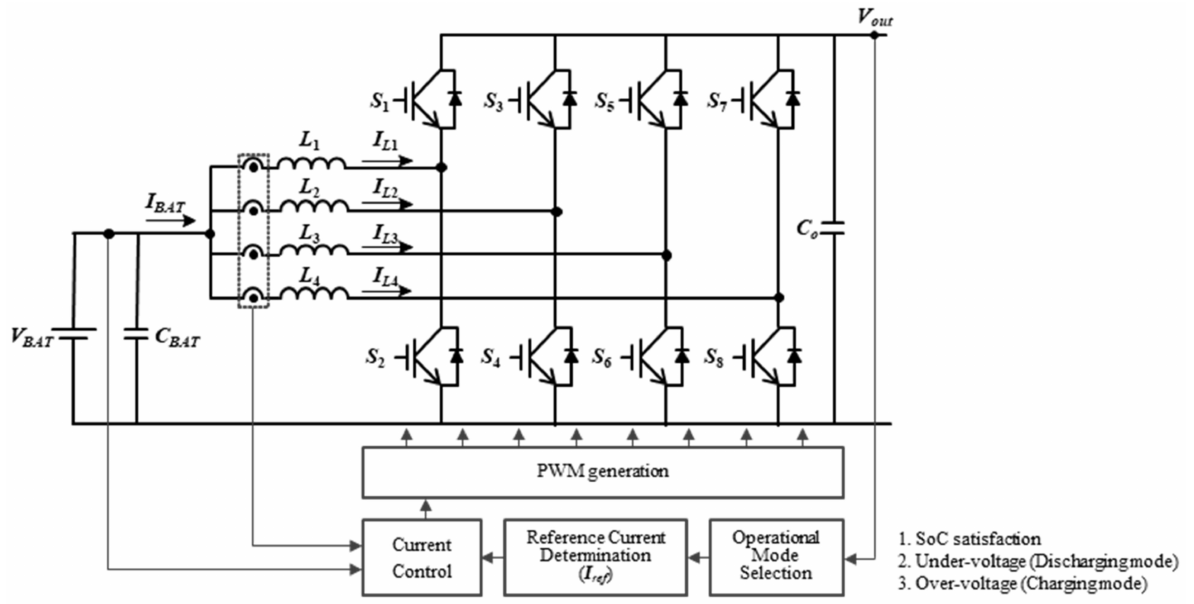
Figure 7. Bidirectional power interface for distributed